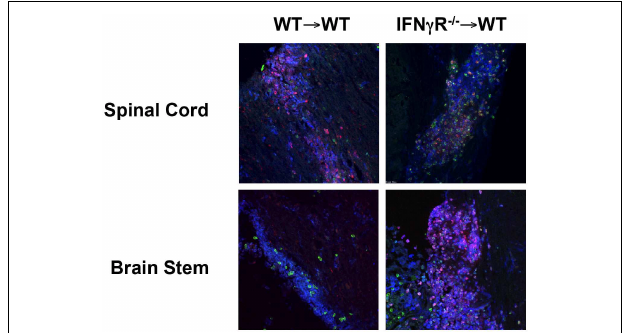
FIGURE 3 | Neutrophils are present in spinal cord lesions in both WT → WT and IFNGR − / − → WT chimeras, but are only present in the brain stem of IFNGR − / − → WT chimeras. The generation of BM chimeras and EAE induced were performed as for Figures 1 , 2 , respectively. On day 10 after EAE induction mice were perfused and frozen sections (10 µ m) of the spinal cord and brain stem were generated as described (Shriver and Dittel, 2006). The sections were stained with anti-mouse CD11b (blue), anti-mouse TCR β (green), and anti-mouse Ly6C (red) and visualized by confocal microscopy. Scale bar: 20 µ